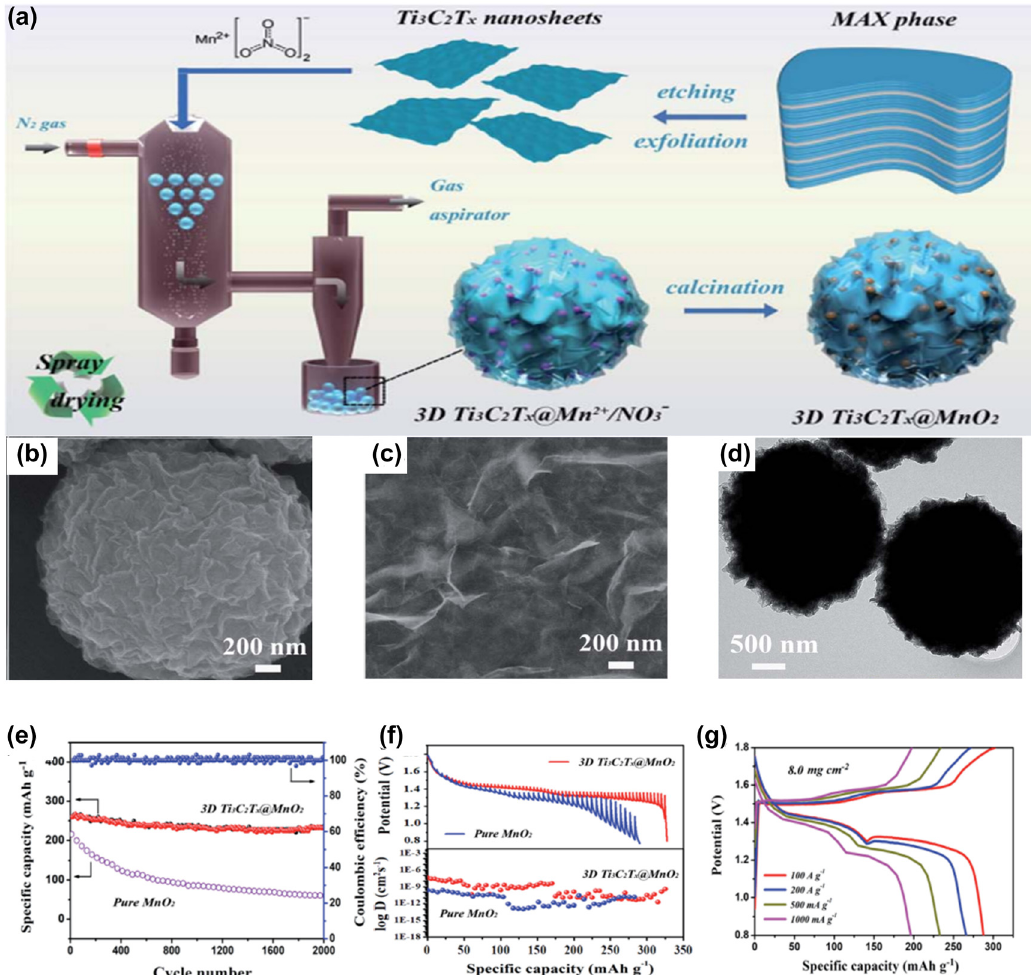
Figure 7: The structure and electrochemical performance of MXene composites anode for SIBs. (a) Schematic illustration of the synthesis process of 3D Ti